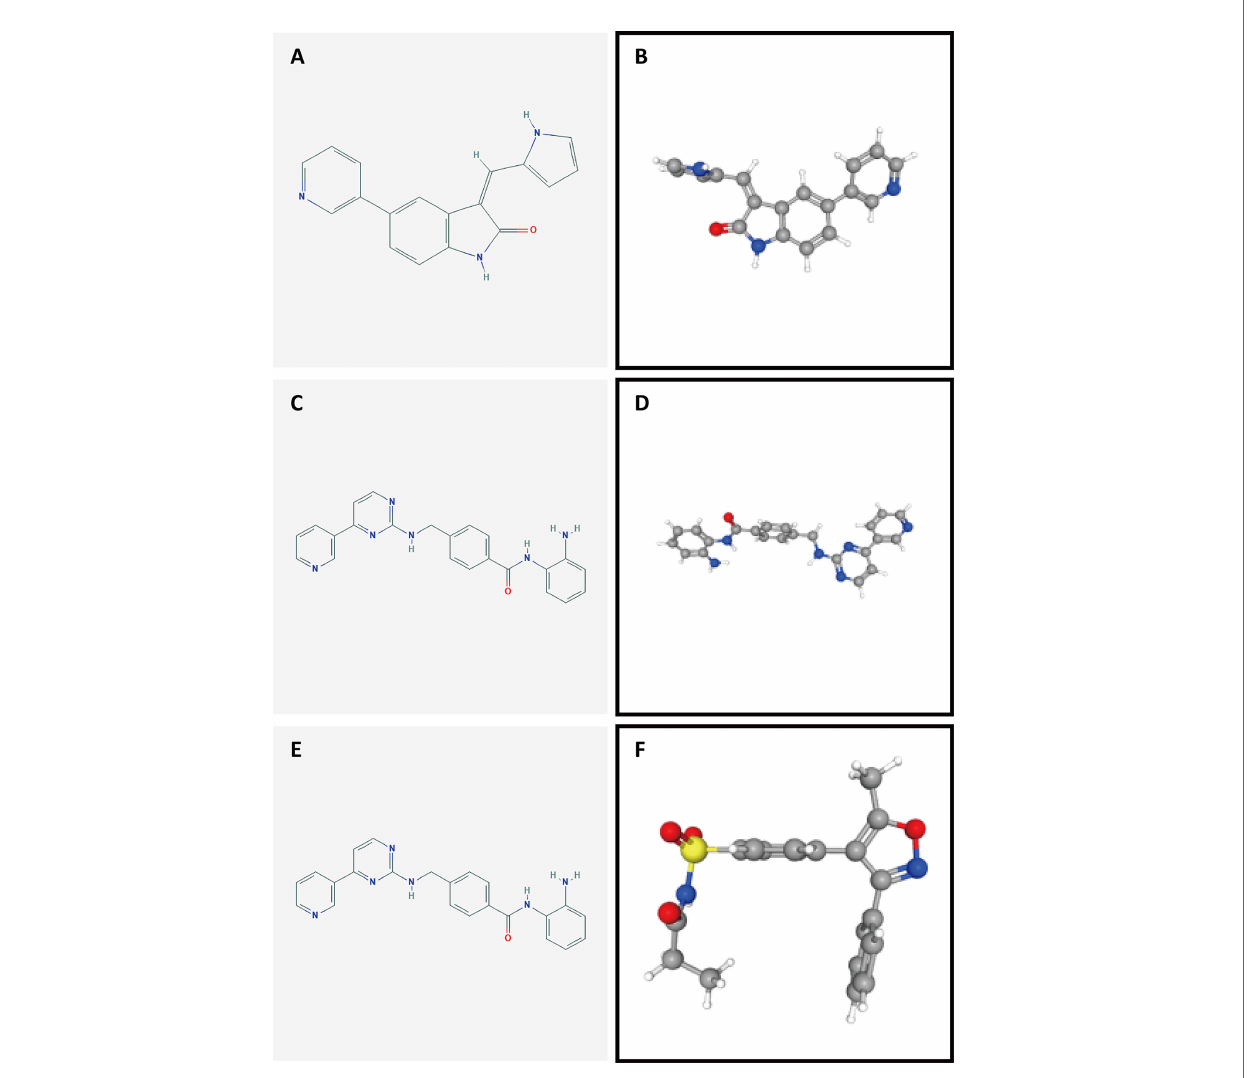
FIGURE 10 | Structures of the screened small-molecule compounds. DEGs were uploaded to the L1000FWD website to screen for potential small-molecule compounds. The top three compounds were visualized using the PubChem website. (A, B) 2D and 3D structures of JAK3-inhibitor-VI. (C, D) 2D and 3D structures of mocetinostat. (E, F) 2D and 3D structures of